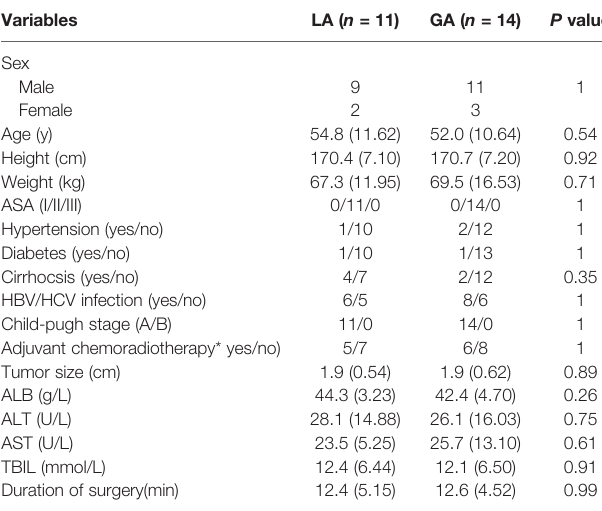
TABLE 1 | General characteristics of the thermal ablation surgery patients [Mean (SD) or